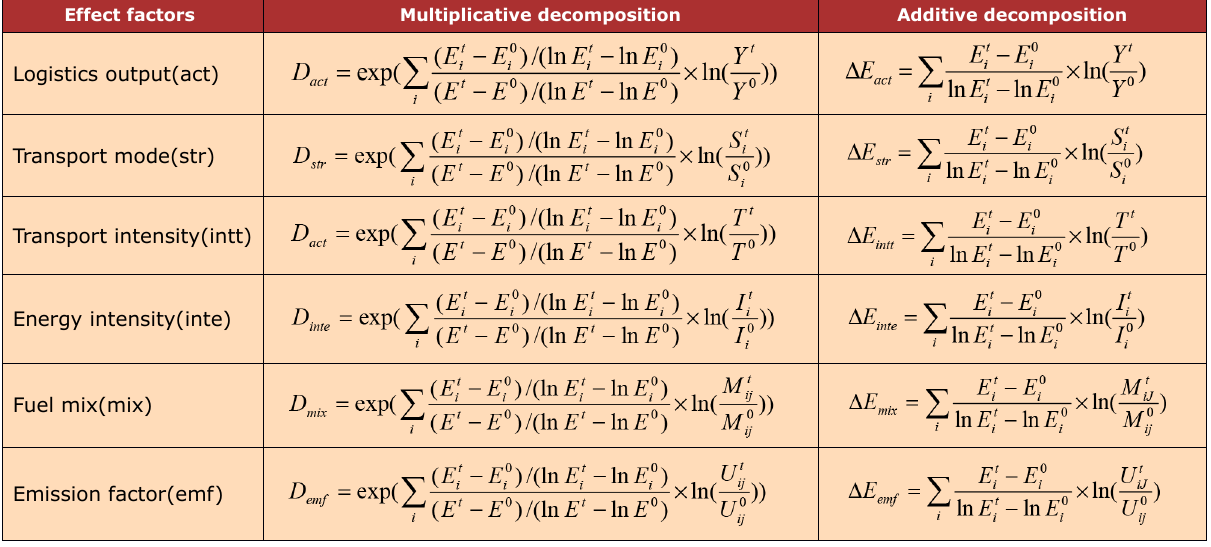
Table A1. Calculation formula of